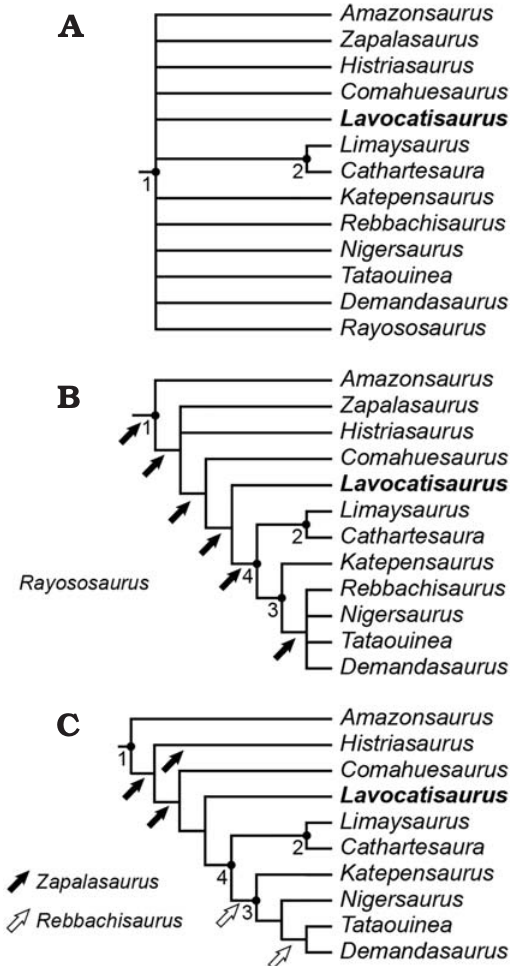
Fig. 4. Results of the phylogenetic analysis. A. Strict consensus tree of the 49 500 most parsimonious trees found, showing a complete polytomy amongst Rebbachisauridae with the sole exception of Limaysaurinae. B . Reduced consensus tree after pruning Rayososaurus , showing all possi- ble positions of this taxon. C . Reduced consensus tree after pruning Rayo- so saurus , Zapalasaurus , and Rebbachisaurus (whose possible positions are indicated by the arrows). Resolved clades are indicated with